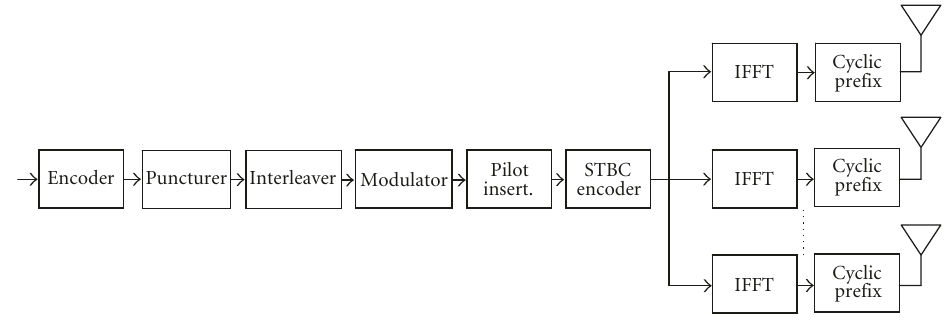
Figure 1: OSTBC OFDM